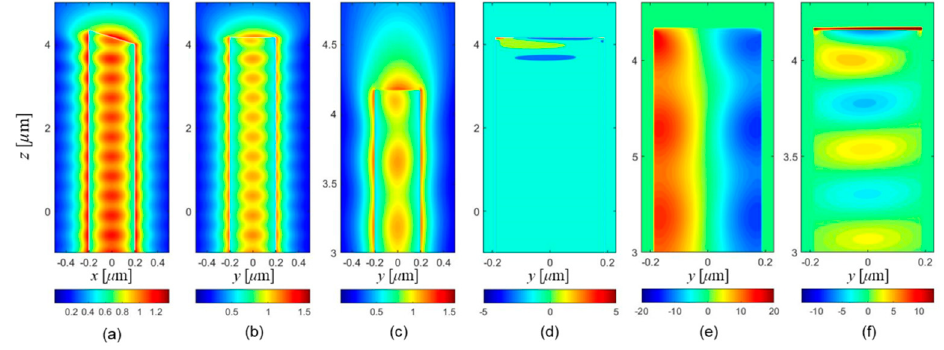
Figure A1. For an oblique endface ( θ = 50°) by right-circular polarized excitations, transverse cross-sectional plots of optical fields in ( a ) x-z plane ( y = 0 μ m), ( b ) y-z plane ( x = 0 μ m), ( c ) enlarged y-z plane ( x = 0 μ m) and corresponding optical force density ( d ) F x , ( e ) F y , ( f ) F z in the y-z plane ( x = 0 μ m).